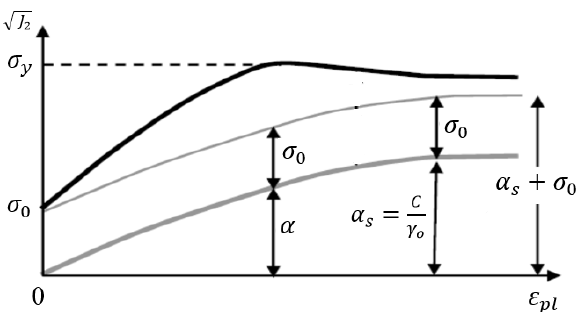
Figure 1. Simplified 1D representation of a kinematic hardening process.